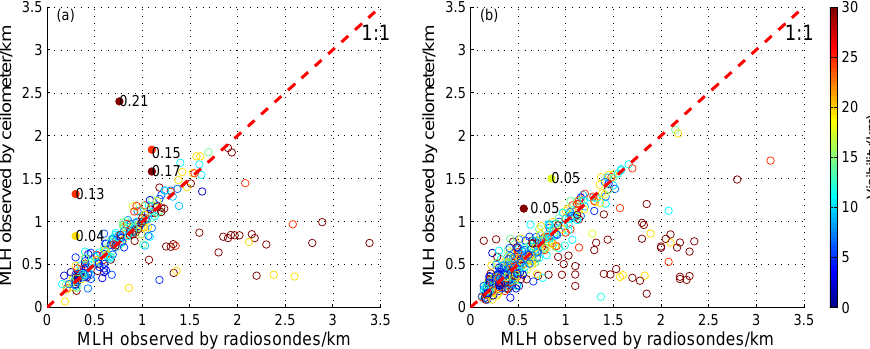
Figure 2. Comparison of MLH between radiosondes and the ceilometer according to visibility for convective (a) and stable (b) states, the number marked with the solid circle refers to the ratios of PM 2 . 5 to PM 10 when sand-dust is crossing.